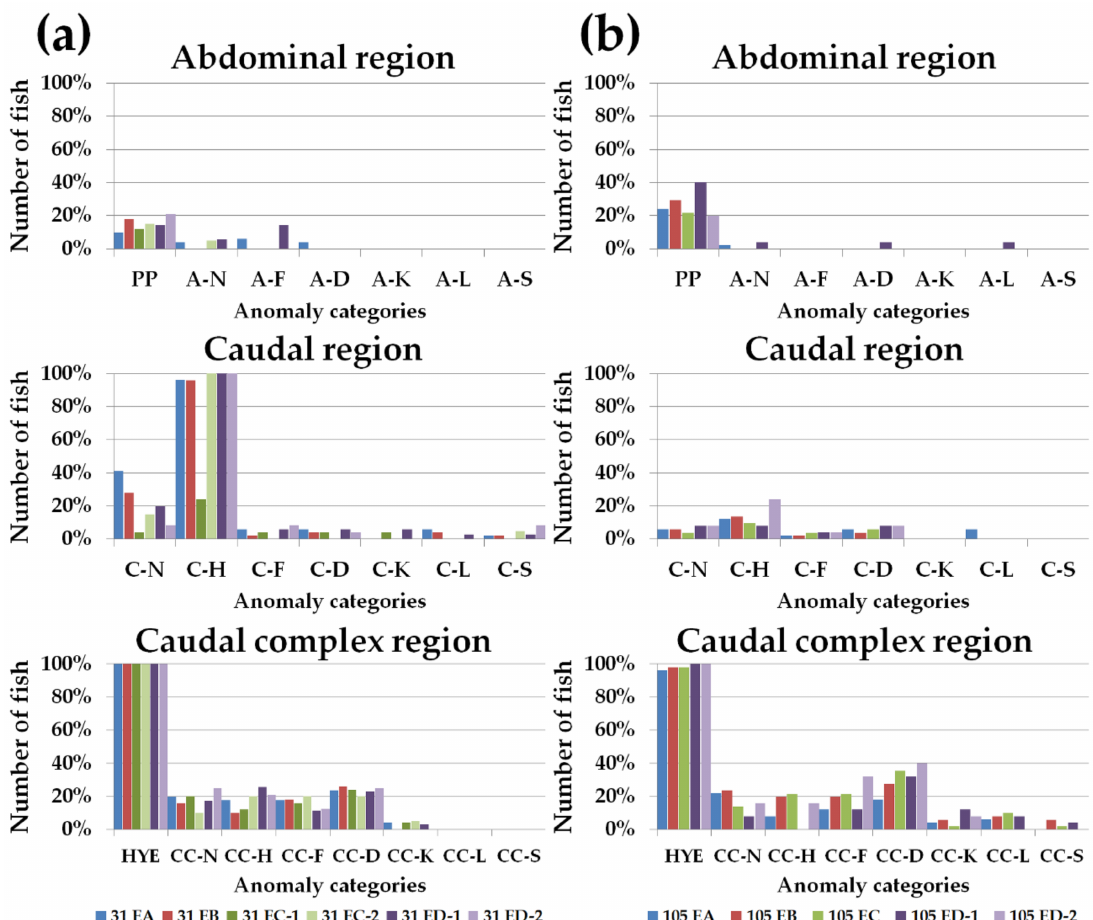
Figure 3. Relative frequency (%) of individuals with at least one anomaly for each group (31 EA, 31 EB, 31 EC-1, 31 EC- 2, 31 ED-1, 31 ED-2, 105 EA, 105 EB, 105 EC, 105 ED-1, 105 ED-2) regarding the anatomical regions. ( a ) 31 days after hatching (dah). Haemal caudal elements and the structures of the caudal complex were the most affected; ( b ) 105 dah. The caudal complex region presented the highest frequency of anomalies. A-D: abdominal (A) deformation; A-F: A fusion; A-K: A kyphosis; A-L: A lordosis; A-N: A neural elements; A-S: A scoliosis; CC-D: caudal complex (CC) deformation; CC-F: CC fusion; CC-H: CC haemal elements; CC-K: CC kyphosis; CC-L: CC lordosis; CC-N: CC neural elements; CC-S: CC scoliosis; C-D: caudal (C) deformation; C-F: C fusion; C-H: C haemal elements; C-K: C kyphosis; C-L: C lordosis; C-N: C neural elements; C-S: C scoliosis; HYE: hypurals, epural, parhypural; PP: